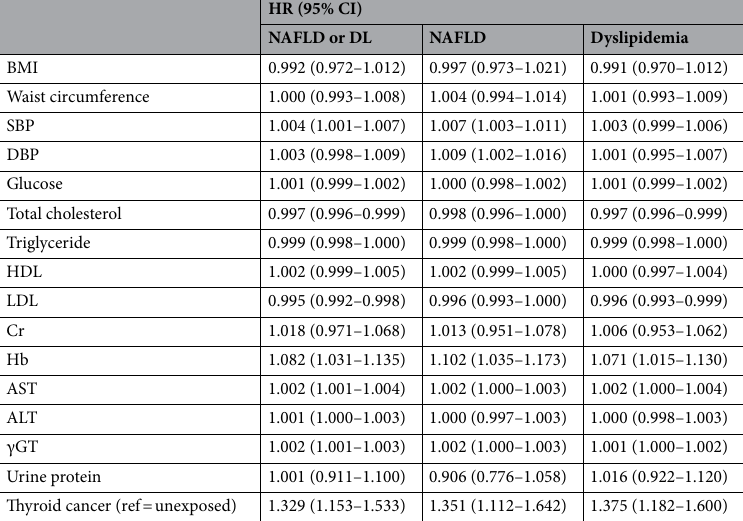
Table 2. Cancer risk estimation by univariable stratified Cox regression analysis result after exact matching in Korean national cohort. BMI body mass index, SBP systolic blood pressure, DBP diastolic blood pressure, HDL high density lipoprotein, LDL low density lipoprotein, Hb hemoglobin, Cr creatinine, AST aspartate transaminase, ALT alanine transaminase, γGT gamma-glutamyl transpeptidase.